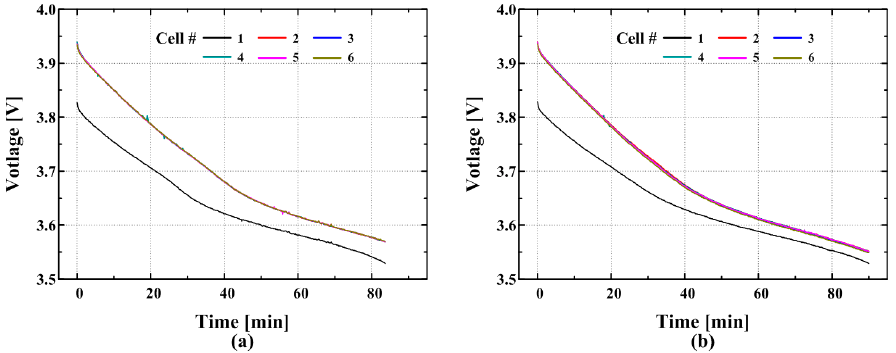
Figure 11. Voltage versus discharging time for the battery pack: ( a ) cell-to-pack balancing in discharging operation and ( b ) pack-to-cell balancing in discharging operation.